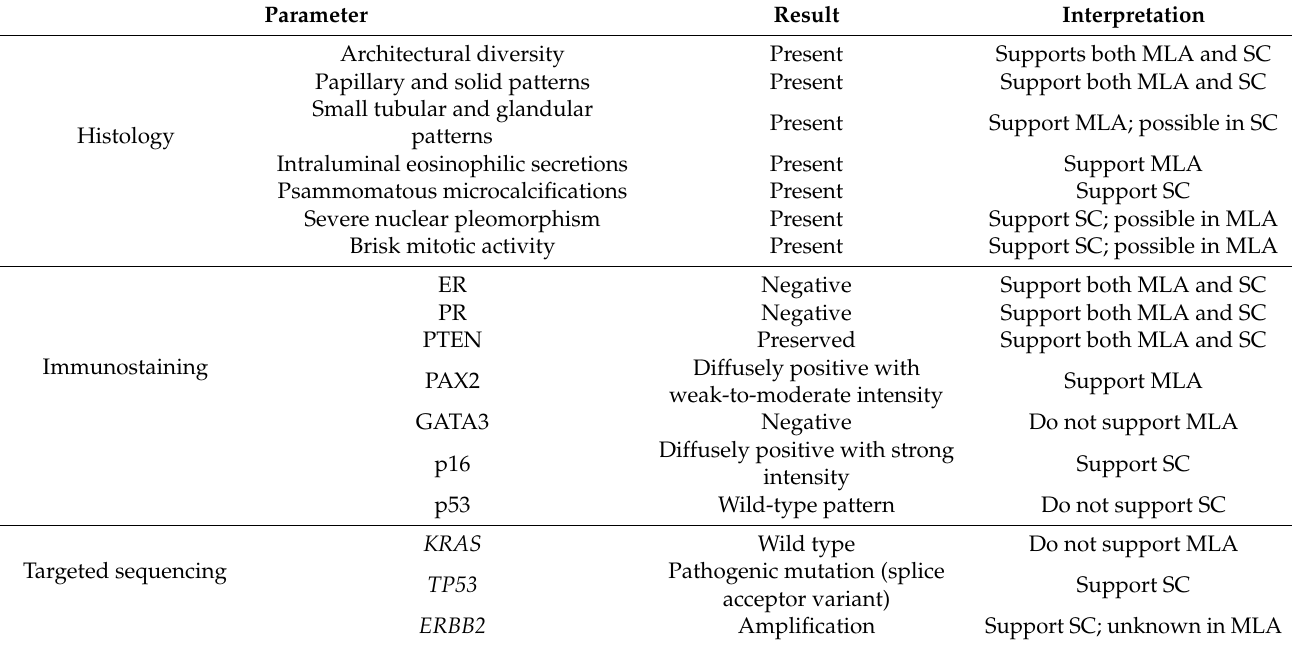
Table 1. Summary of histological features, immunostaining results, and targeted sequencing